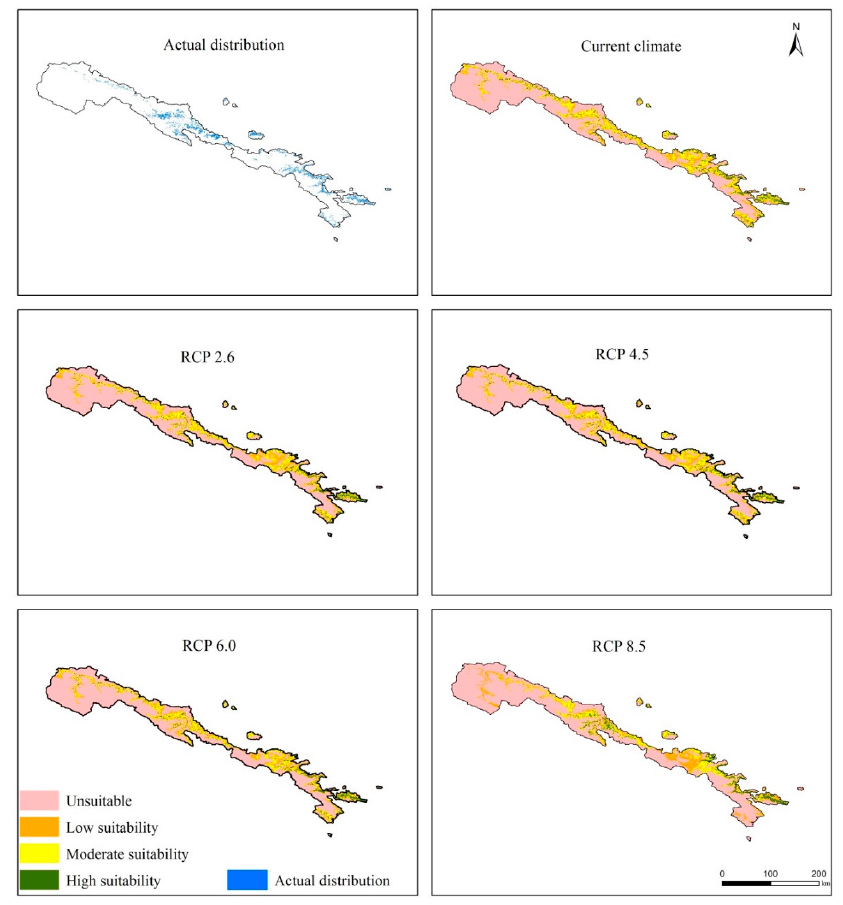
Figure 4. The actual distribution and potential of Qinghai spruce under current climate and four scenarios. Table 4. Habitat suitability classes area of Qinghai spruce.